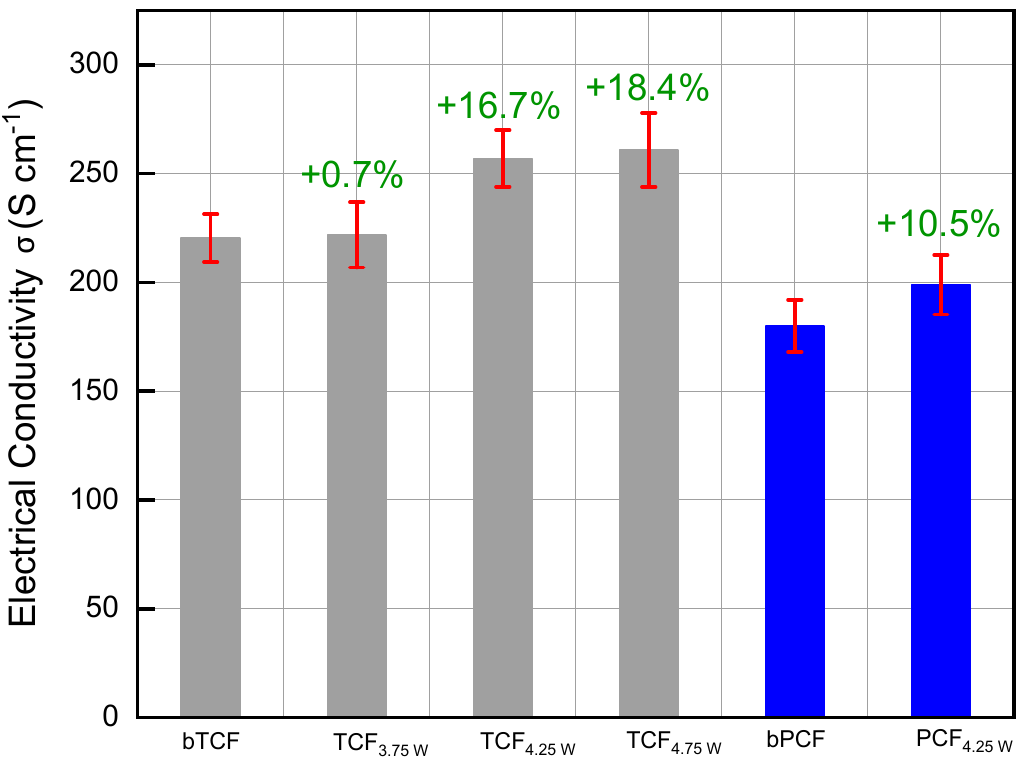
Figure 10. Electrical conductivity ( σ ) of all irradiated yarns. Table 2. Tensile strength and electrical conductivity ( σ ) of all irradiated samples.